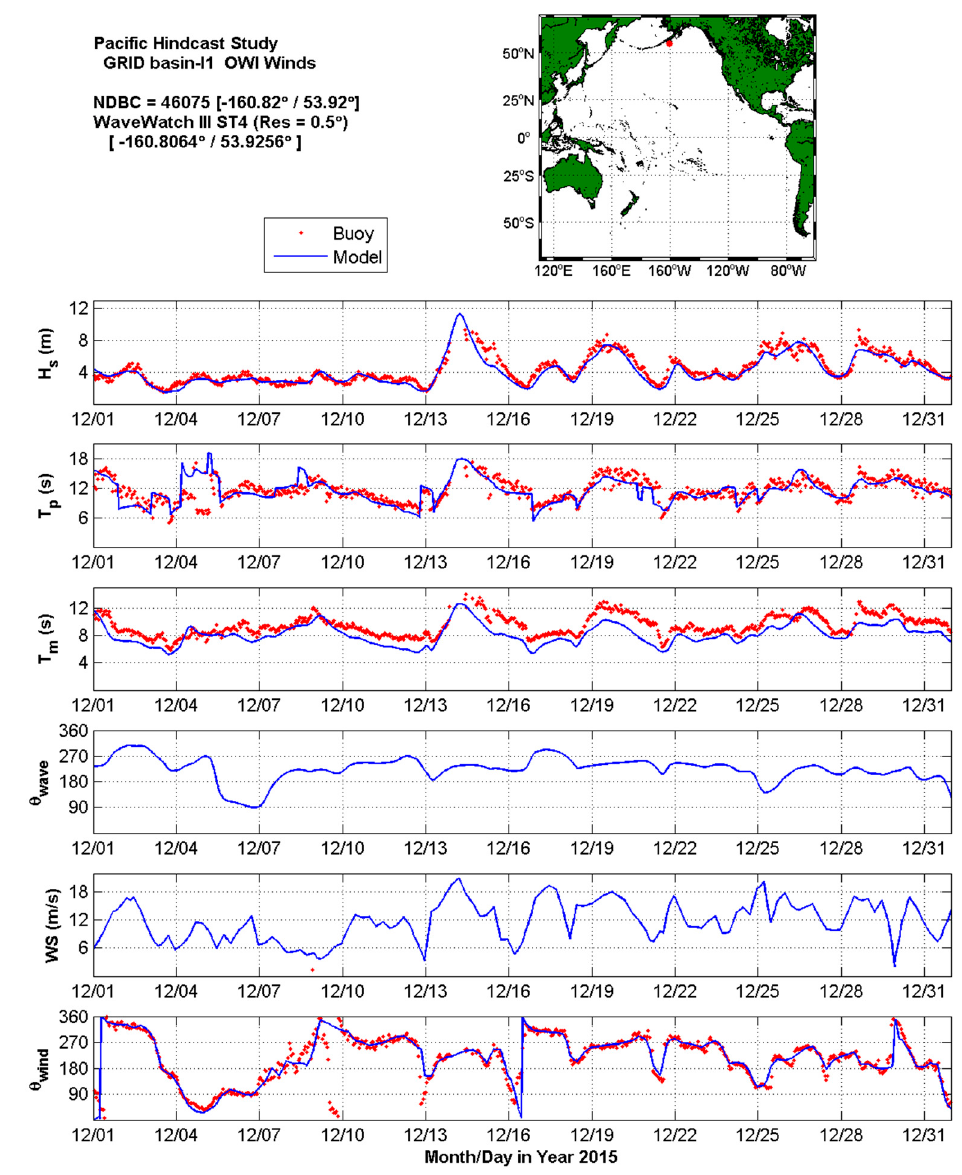
Figure 2. Wave model performances compared with buoy